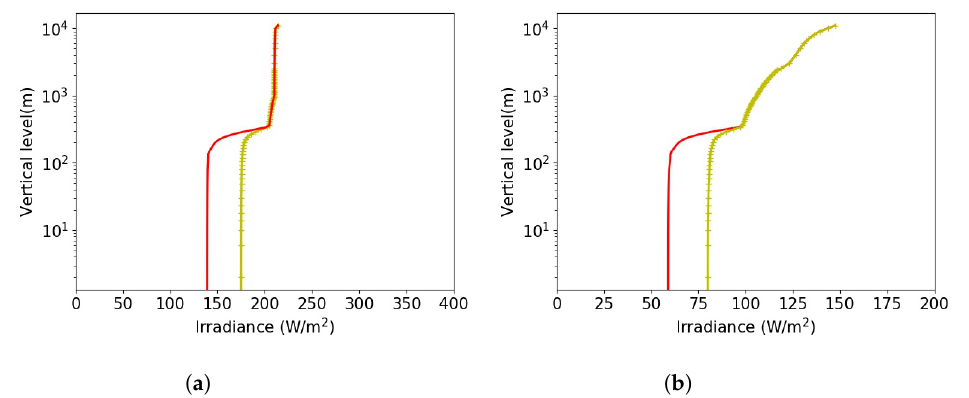
Figure 6. Downward global fluxes in the atmospheric layers at 0900 (UTC) on the 19 of February for UV-vis band ( a ) and for SIR band ( b ) ( — base case; -+- constant cloud droplet’s effective radius of 10 µ